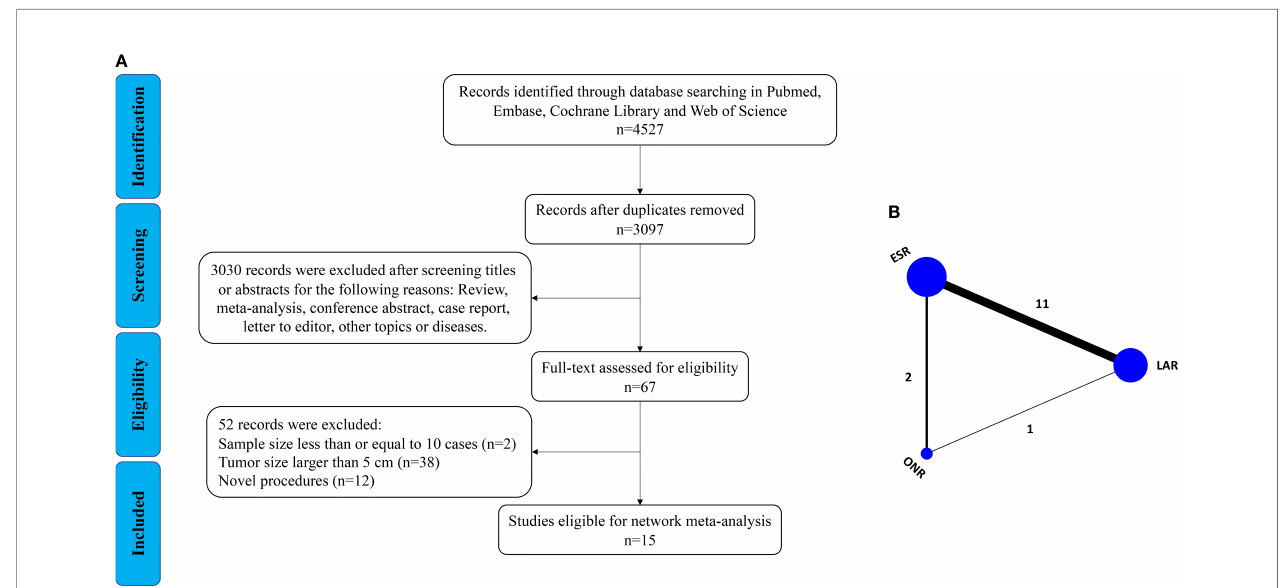
FIGURE 1 | Flow chart of the (A) search strategy and (B) study